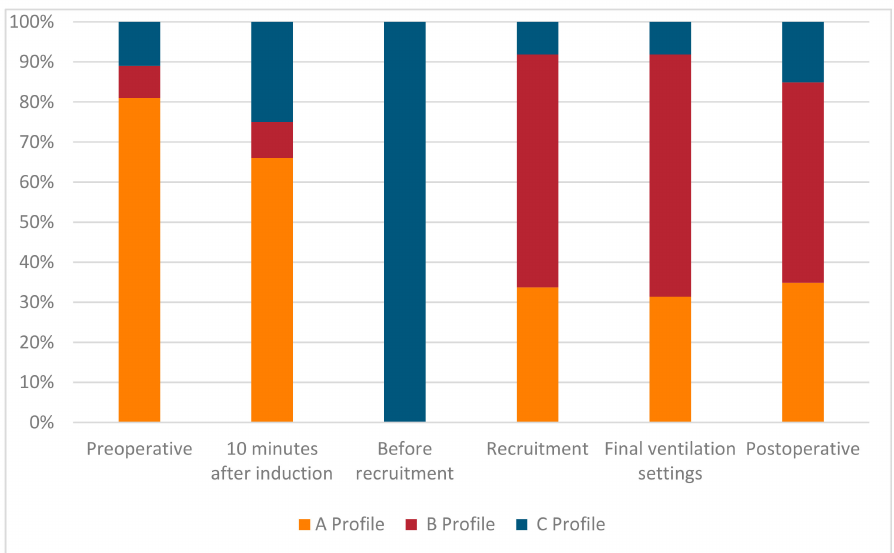
Figure 5. Percentage distribution of results at consecutive stages of lung ultrasound assessment.